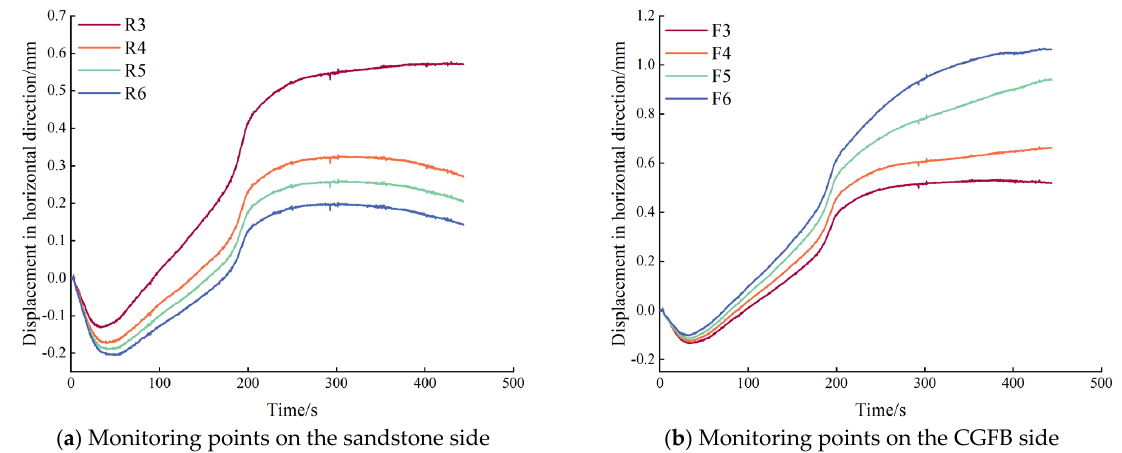
Figure 15. ( a ) R3–R6 and ( b ) F3–F6 horizontal-direction displacement change curves. Figure 15b shows the displacement evolution curves of measurement points F3–F6 in the horizontal direction. From 0 to 30 s of sample loading, measurement points F3–F6 gradually moved to the left with peaks at −0.132, −0.125, −0.116, and −0.101 mm, respectively, and they gradually decreased with increasing distance from the intersection. From 30 to 180 s, F3–F6 moved to the right, and the displacement grew at a uniform rate. The growth rate of measurement point displacement increased gradually with increasing distance from the intersection. The displacement growth rate of F3–F6 peaked from 180 to 200 s of sample loading. The displacement of measurement point F3 stabilized at 0.52 mm from 200 to 443 s. The displacement of F4–F6 increased continuously, reaching 0.663, 0.914, and 1.063 mm at the time of sample destabilization. The results revealed that the interface effect had the strongest inhibitory effect on the horizontal deformation of the filling near the boundary; therefore, F3 maintained a high stability under the interface effect.